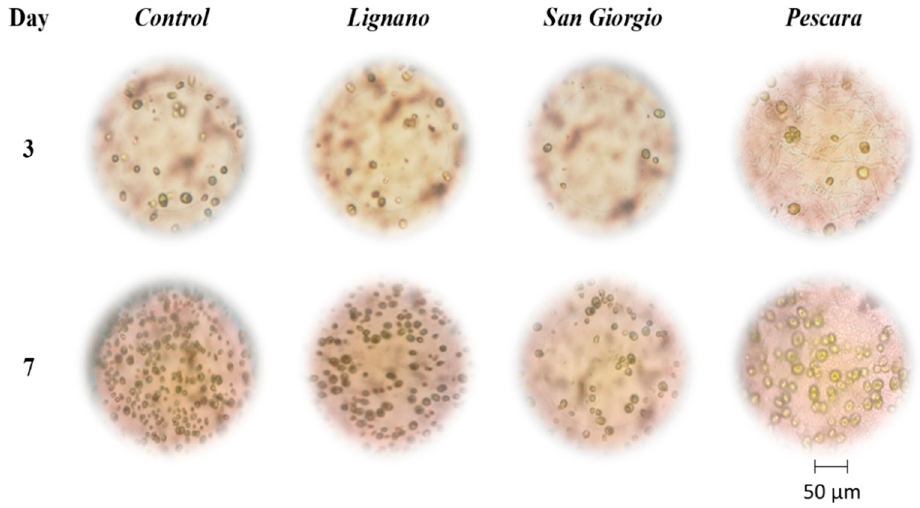
Figure 3. Optical microscopy images of algae cells grown in control medium and wastewater samples from depuration plants in Lignano, San Giorgio, and Pescara (Italy).